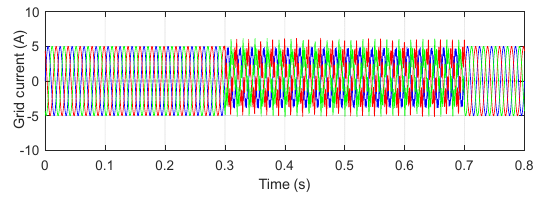
Figure 8. Grid current under grid fault condition.